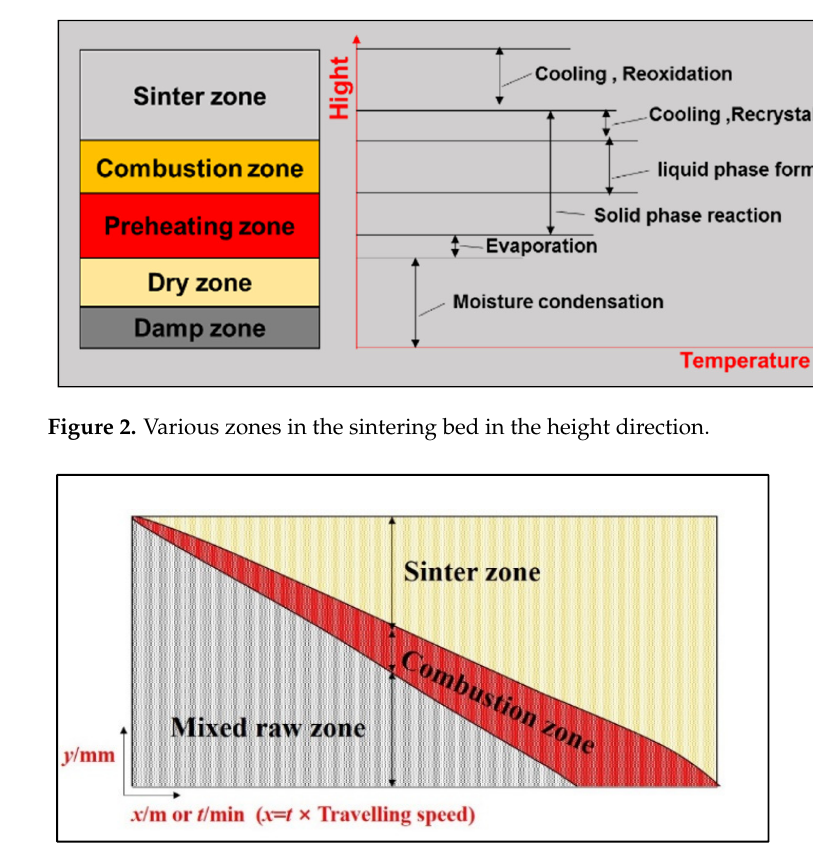
Figure 1. Schematic of the sintering process.